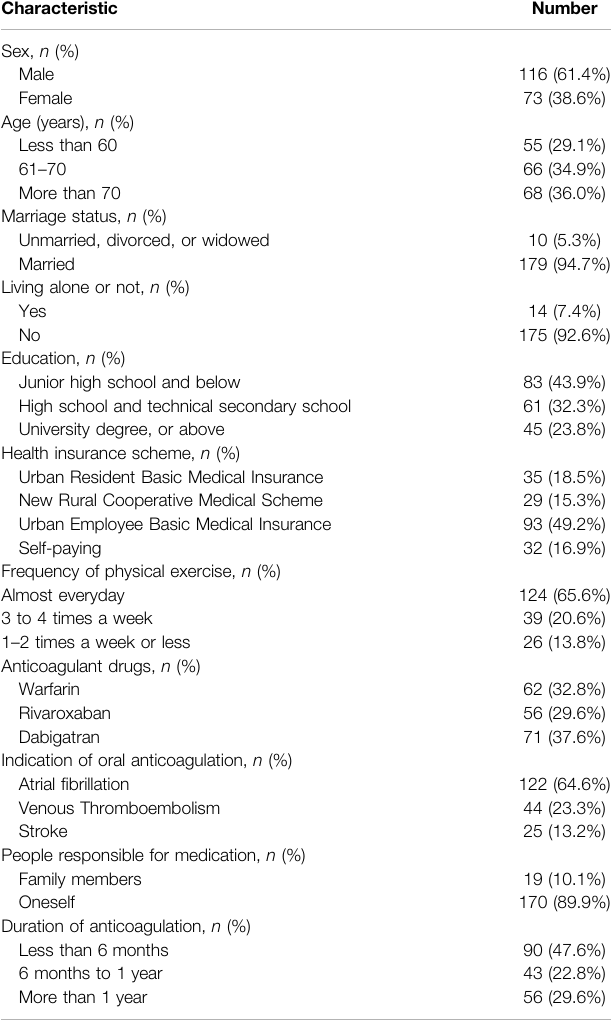
TABLE 1 | Sociodemographic and clinical characteristics of the